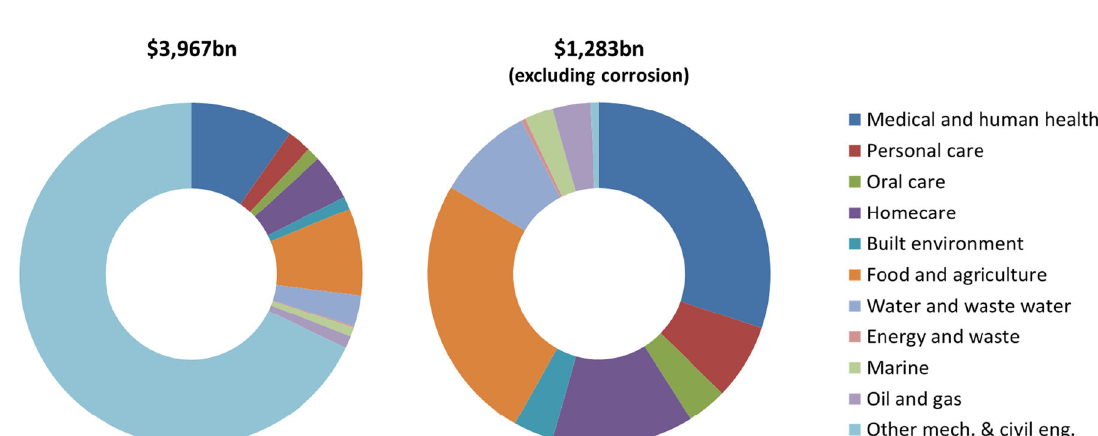
Fig. 1 Economic signi fi cance of bio fi lms by sector. Corrosion has been removed from the right chart to expand the viewing of the other